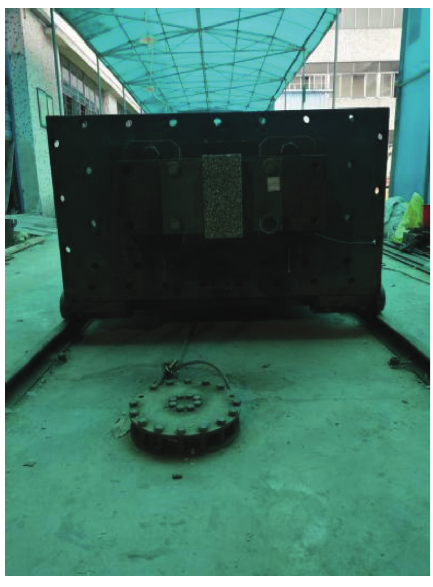
Figure 9: Horizontal traction impact test